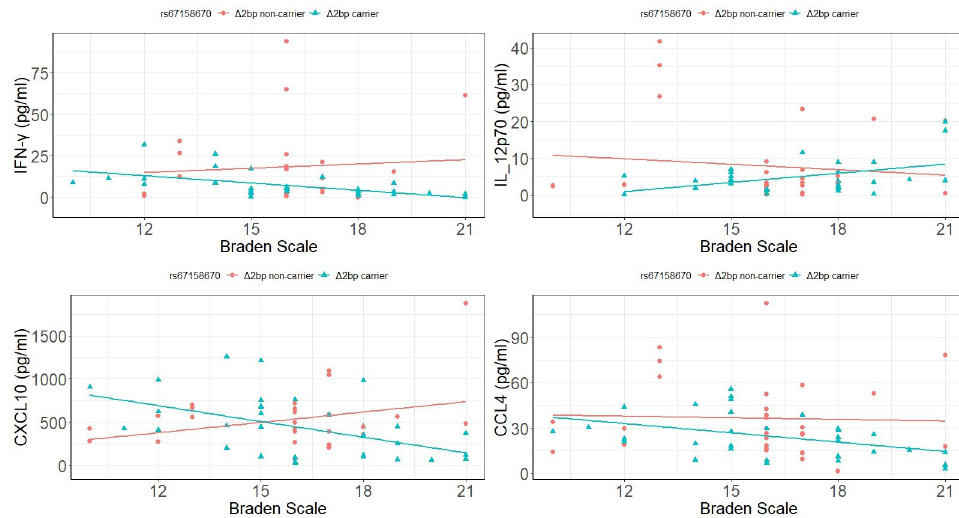
Fig 3. Association of inflammatory mediators with Braden scale in mild SCI is a function of